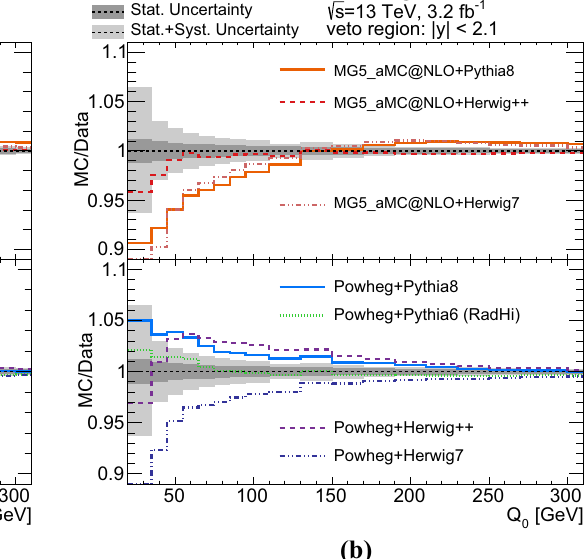
samples are shown as ratios to data, with the data uncertainty indicated by the shaded band , and the Q 0 thresholds corresponding to the left edges of the histogram bins , except for the first